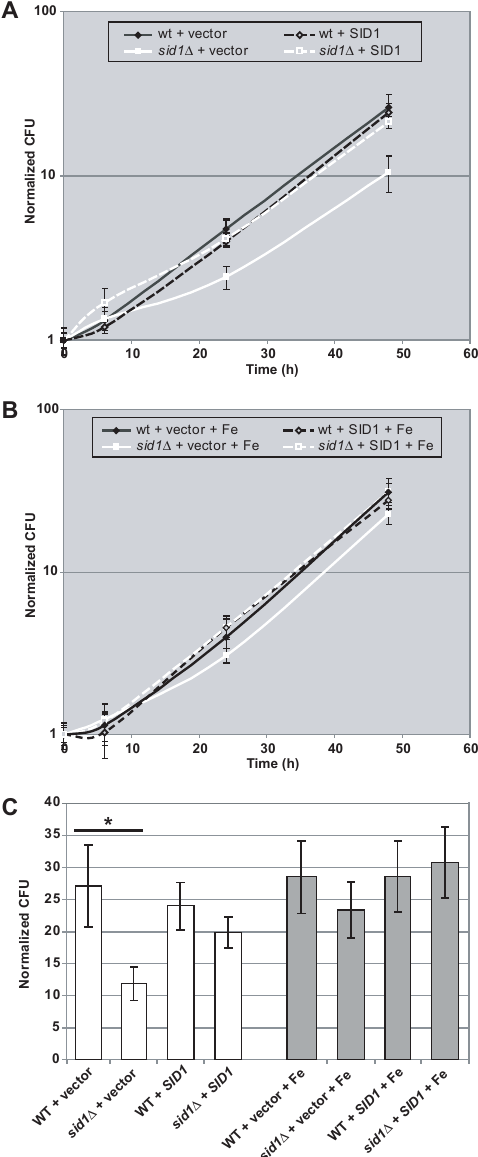
Figure 4. Disruption of SID1 Results in Impaired Growth During Infection of Macrophages. HcLH95 (WT + vector), HcLH97 ( sid1 D +- vector), HcLH103 (WT + SID1 ), and HcLH106 ( sid1 D + SID1 ) were used to infect C57BL/6J bone-marrow-derived macrophages at a multiplicity of infection of 5. Macrophages were lysed at t=0, 6, 24, and 48 hours, and plated for H. capsulatum colony-forming units (CFUs) on HMM. CFUs were normalized to the zero time point. Infected macrophages were incubated in either BMM (A) or BMM + 100 m M FeSO 4 (B) Data from a representative time course is shown. The average of three platings + / 2 standard error of the mean is shown. Significance was determined using ANOVA with Bonferroni Multiple Comparisons Test. Comparison of wt + vector and sid1 D + vector at 48 hours has a p , 0.001. The experiment was repeated three times with two independently isolated sid1 D strains, as well as four independently isolated sid1 D + SID1 strains. (C) The average CFU at 48 hours of three independent infections + / 2 standard error of the mean is shown. White bars indicate CFUs from infected macrophages incubated in BMM, grey bars indicate macro- phages incubated in BMM + 100 m M FeSO 4 . Significance was determined for the influence of genotype (WT versus sid1 D ) and iron using three- way ANOVA. Genotype influence, *: p-value , 0.05.